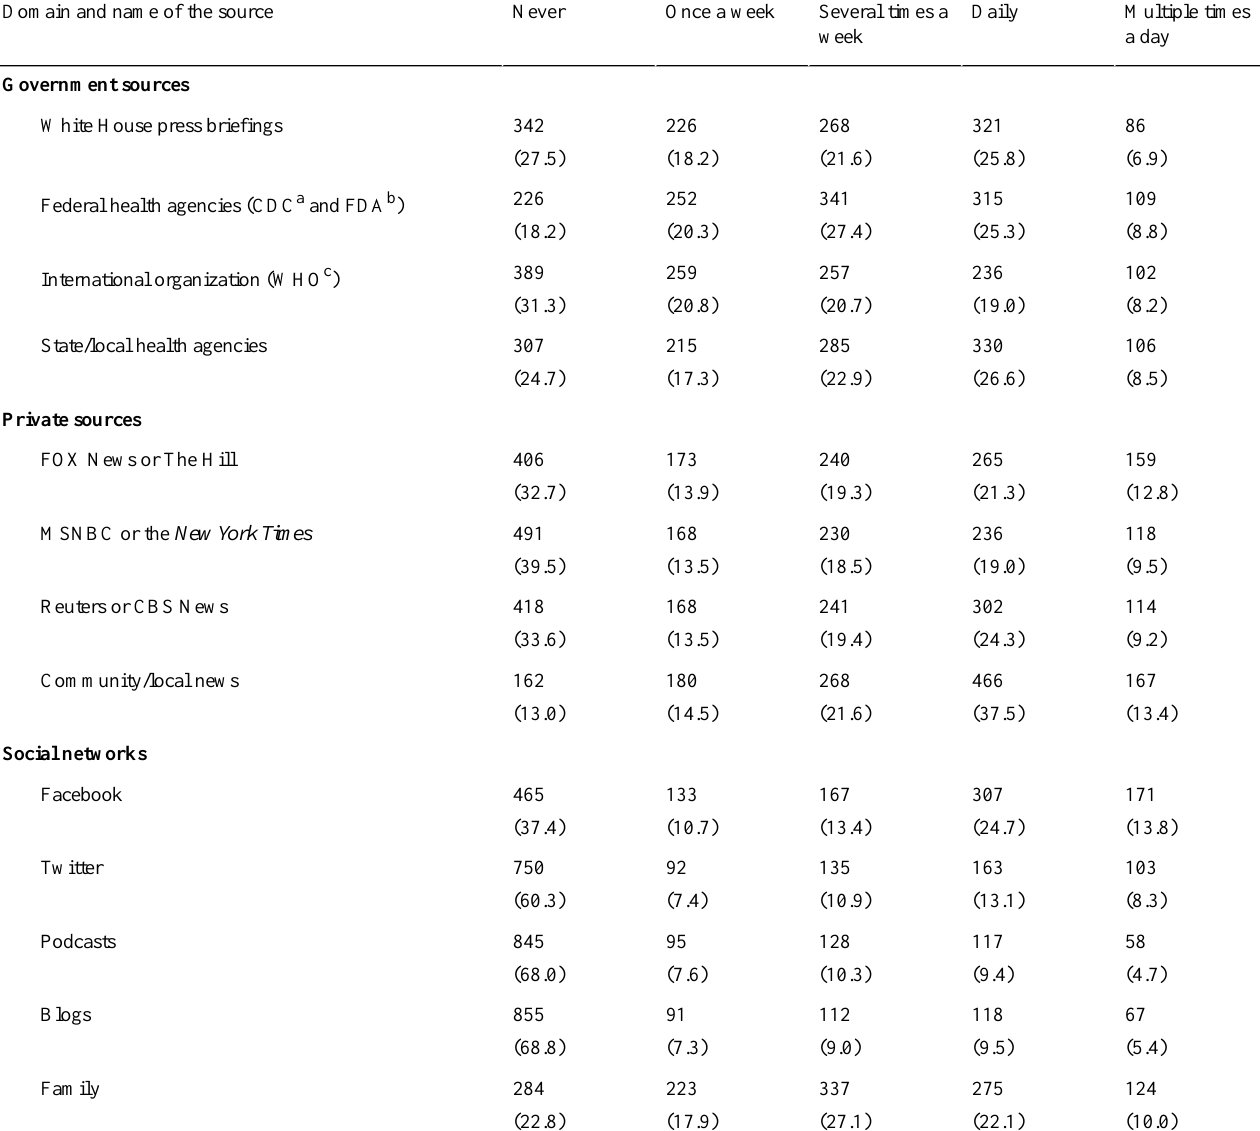
Table 3. Frequency at which participants reported checking information sources to obtain information about COVID-19 by source of information (N=1243), n